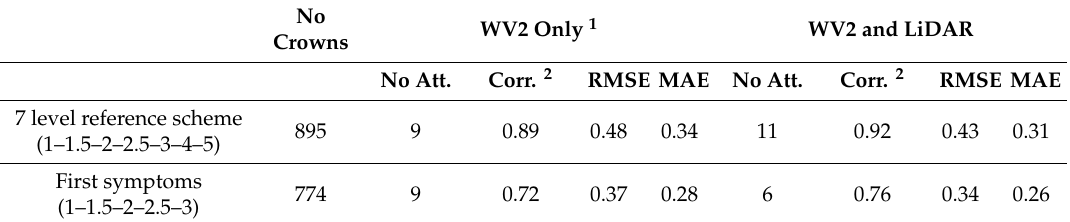
Table 7. Performance of an RF regression for the first stress symptoms and seven stress levels with and without LiDAR attributes. The resulting values are based on individual attribute selections for each setup and crowns with a diameter larger than 4 m (total 895 crowns).